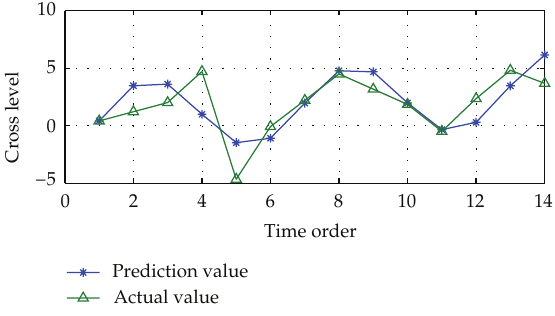
Figure 7: Comparison of actual value and revised predictive value at fixed measuring point.